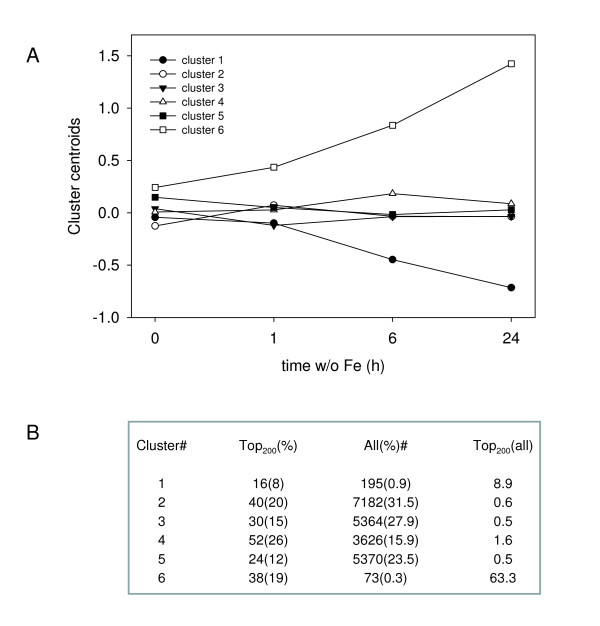
The averaged response of clusters to Fe deficiency. The entire array dataset was subjected to a k-means cluster analysis, and the centroids of these clusters were plotted with respect to time (A). The misrepresentation of significantly expressed gene transcripts is reported below the figure (B). For this analysis, the total frequency of genes found in a cluster was compared to the transcript frequency in the 200 statistically most significant signals.